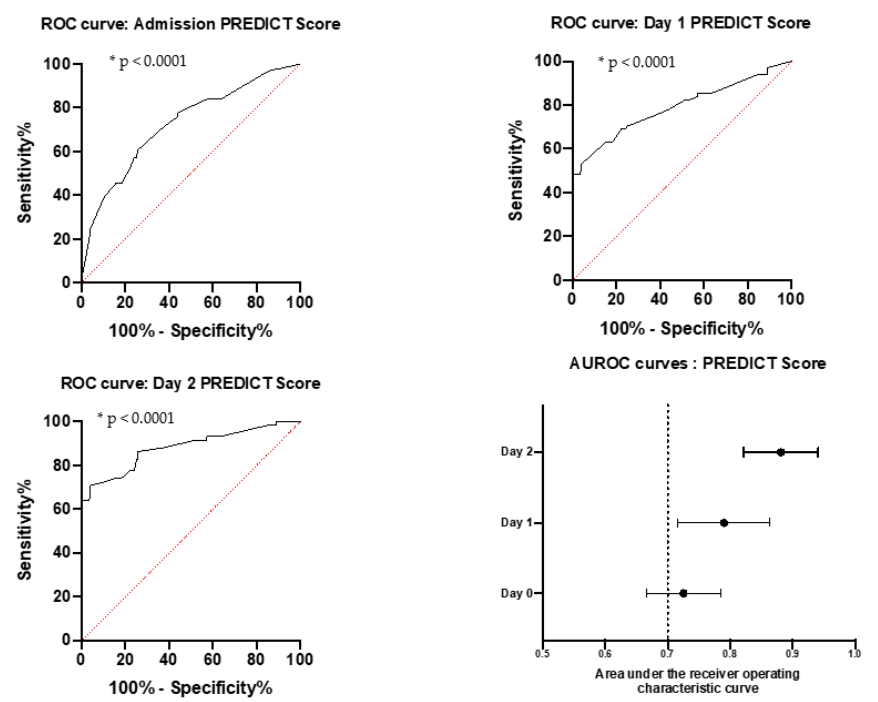
Figure 3. Receiver Operating Characteristic (ROC) curves for PREDICT score on admission in Intensive Care Unit; Day 0, day 1, and day 2 of hospitalization, and area under ROC curve repartition. * p < 0.05